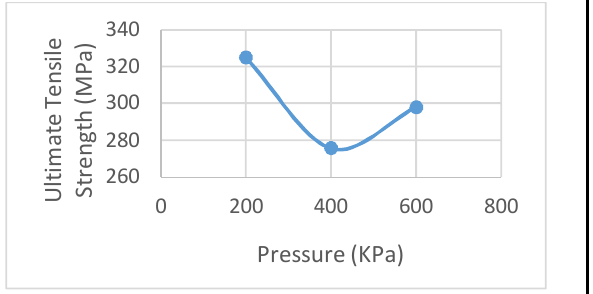
Fig 14: Effect of pressure on the UTS for Aluminum Fig 15: Effect of Pressure on hardness for